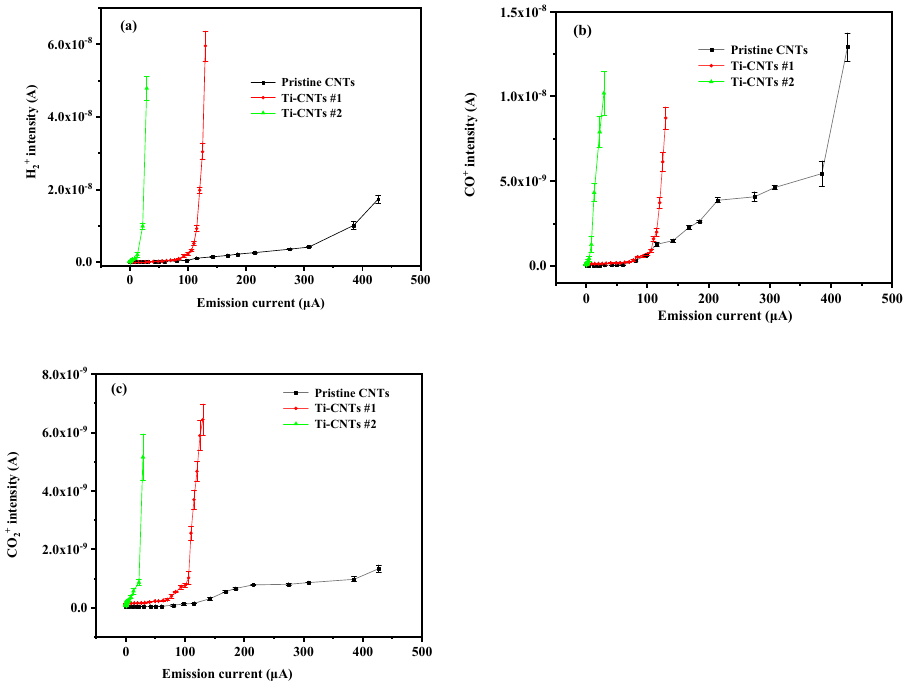
Figure 11. Gas desorption along with variation of FE current for pristine CNTs, CNTs #1 and CNTs #2. ( a ) H 2 + intensity, ( b ) CO + intensity, ( c ) CO 2 + intensity.